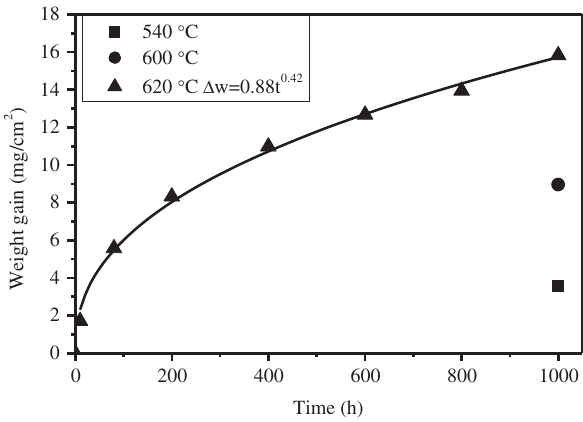
Figure 2: Weight gain for Ferritic Steel T22 sample as a function of time exposed in SCW at 540 – 620°C and 25 MPa.